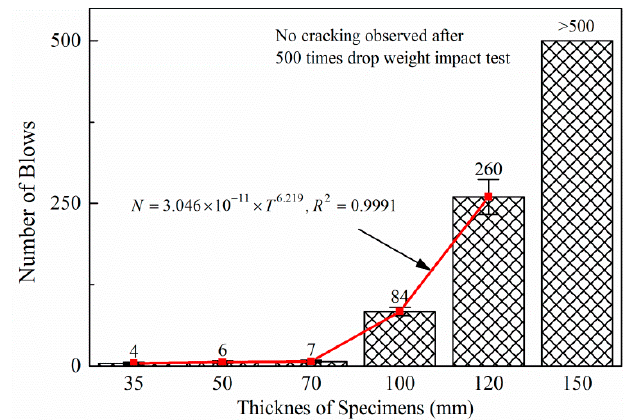
Figure 16. Impact loading test result for different thicknesses.